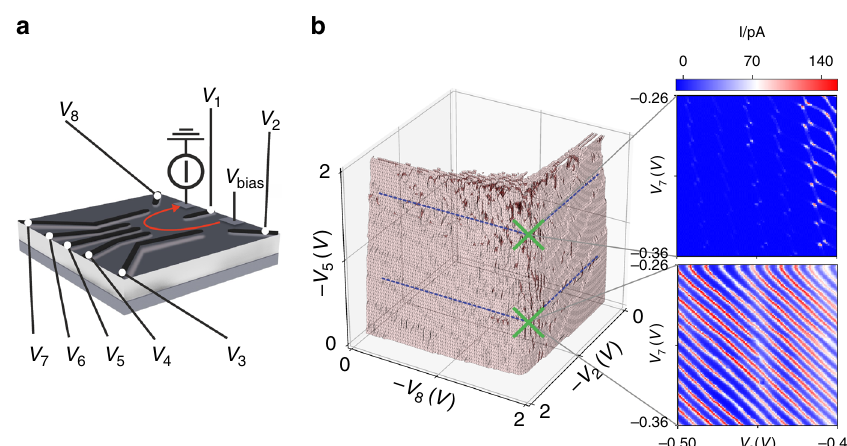
Fig. 1 Overview of device, and gate voltage space. a Schematic of a gate-de fi ned double quantum dot device. b Left: Boundary hypersurface measured as a function of V 2 , V 5 , and V 8 , with fi xed values of V 1 , V 3 , V 4 , V 6 , and V 7 . The current threshold considered to de fi ne this hypersurface is 20% of the maximum measured current. The gate voltage parameter space, restricted to 3D for illustration, contains small regions in which double and single quantum dot transport features can be found. These regions typically appear darker in this representation because they produce complex boundaries. Right: For particular gate voltage locations marked with green crosses, the current as a function of V 7 and V 3 is displayed. The top and bottom current maps display double and single quantum dot transport features, respectively.